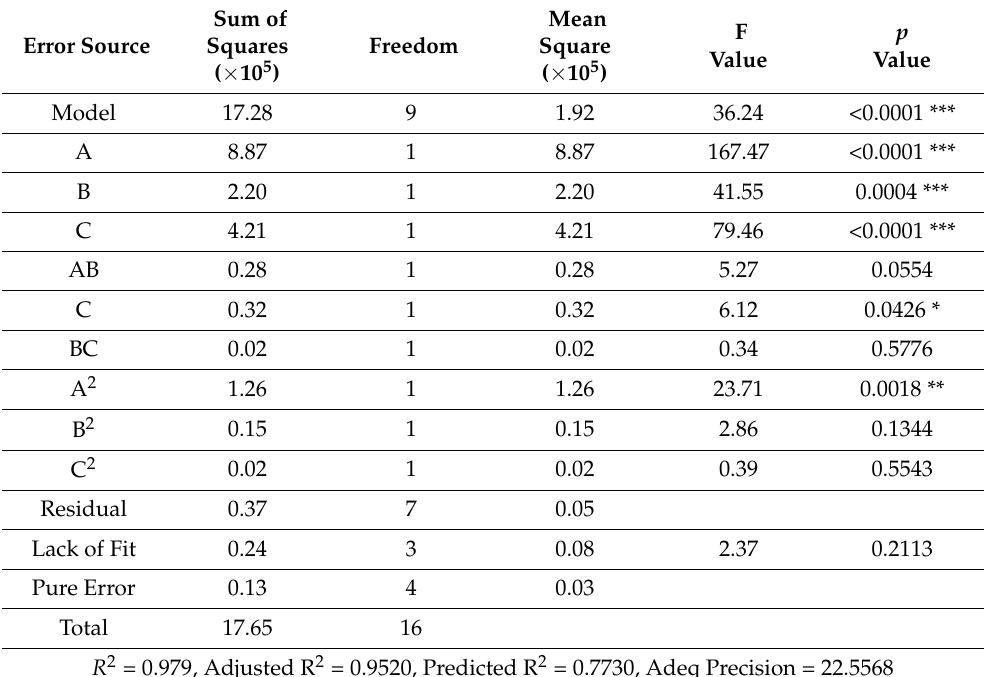
Table 6. Variance analysis of quadratic term model of soil uniformity.